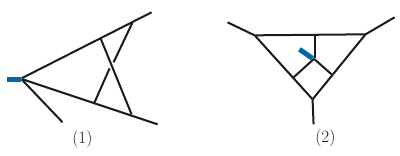
Figure 1 . (1) The 2-loop non-planar topology has vanishing color factor. (2) Nonplanar topology contributing to leading color begins to appear at 3-loop.